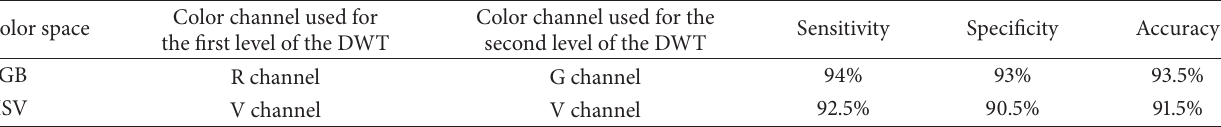
Table 7: Results obtained using the proposed algorithm in RGB and HSV color spaces.